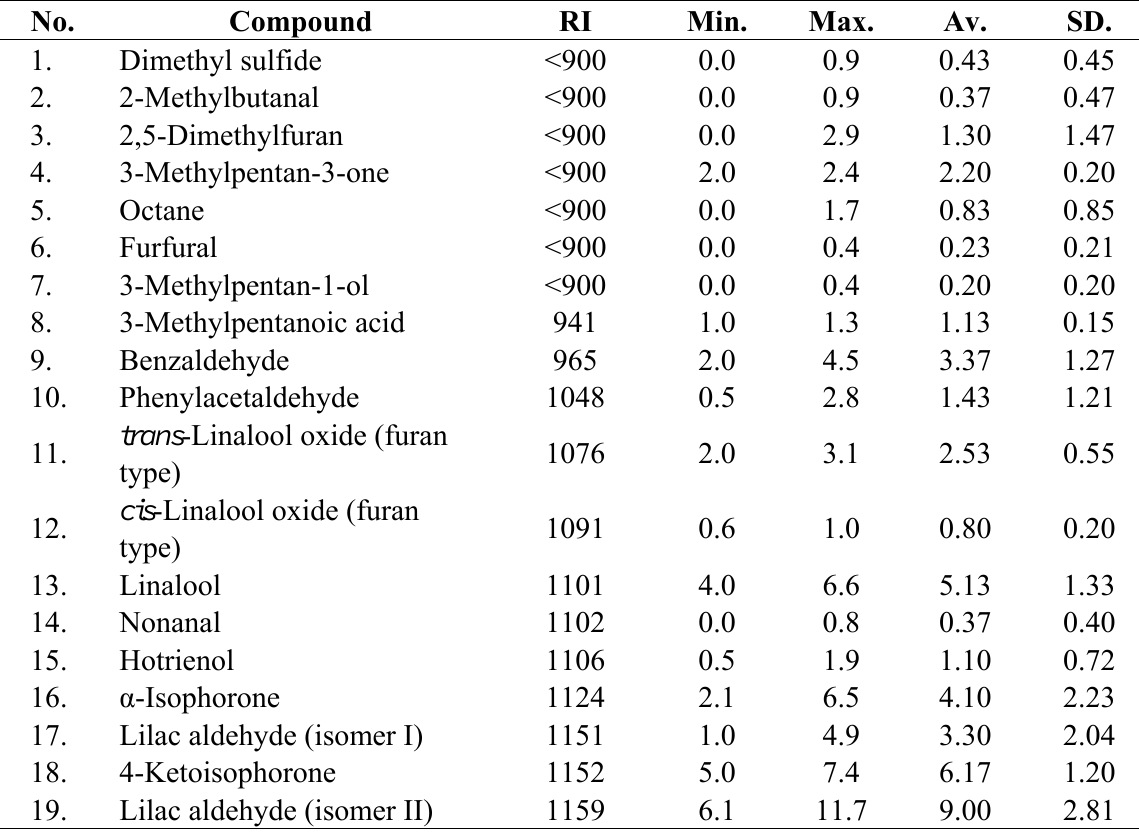
Table 1. Prunus mahaleb L. honey volatiles composition obtained by HS-SPME followed by GC and GC-MS